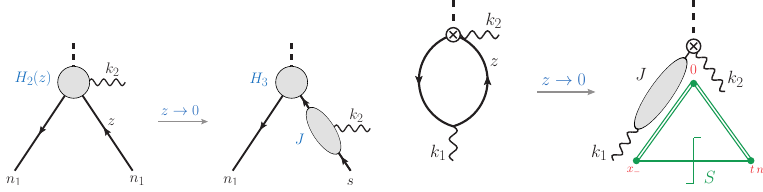
Figure 1: Graphical illustration of the two refactorization